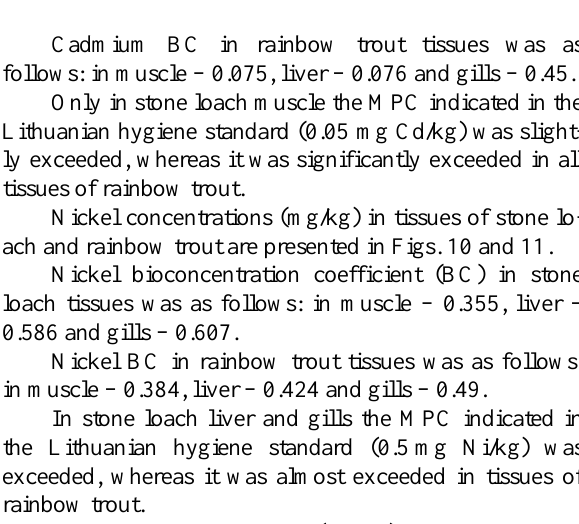
Fig. 11. Nickel concentration (mg/kg) in tissues of rainbow trout